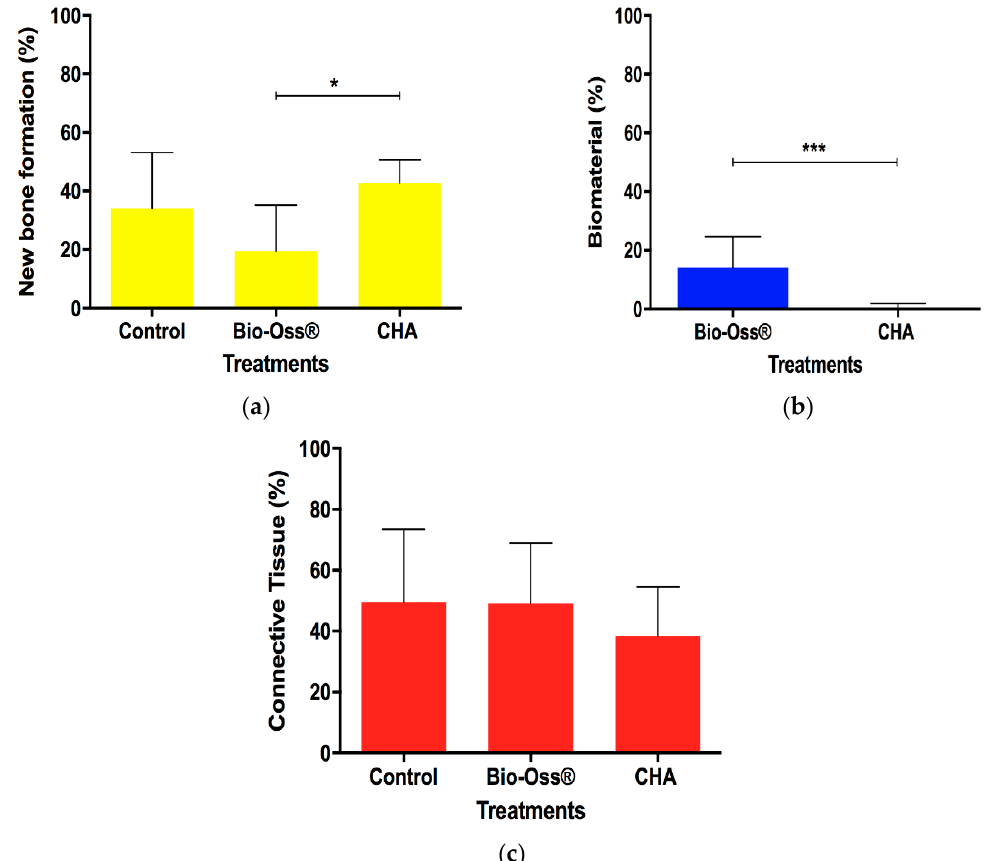
Figure 4. The amount of new bone formation ( a ), reminiscent biomaterial ( b ), and connective tissue ( c ) 90 days after implantation. The horizontal bar represents statistical differences between treatments in the same experimental period. The differences of new bone formation and connective tissue between different treatments were analyzed with two ‐ way ANOVA and Tukey’s post ‐ test ( p < 0.05) and reminiscent biomaterial with Student’s t -test. Results are shown as mean percentages ± confidence